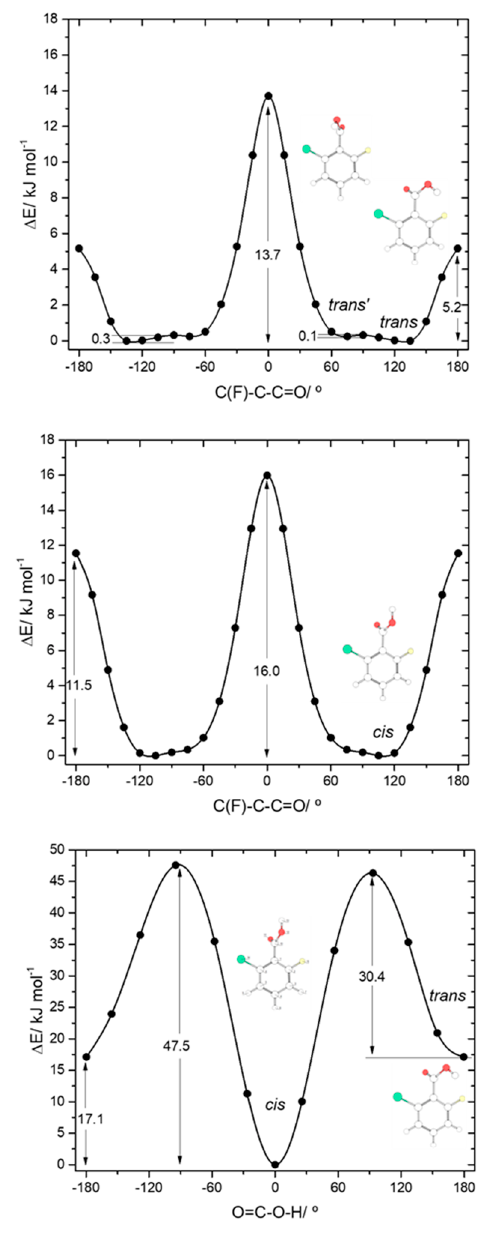
Figure 8. B3LYP / 6-311 ++ G(d,p) calculated potential energy profiles for internal rotation about the exocyclic C-C (for cis and trans arrangement of the carboxylic group) ( top and middle panels ) and about the C-O bond (connecting the cis and trans conformers; bottom panel ) for 2-chloro-6-fluorobenzoic acid.